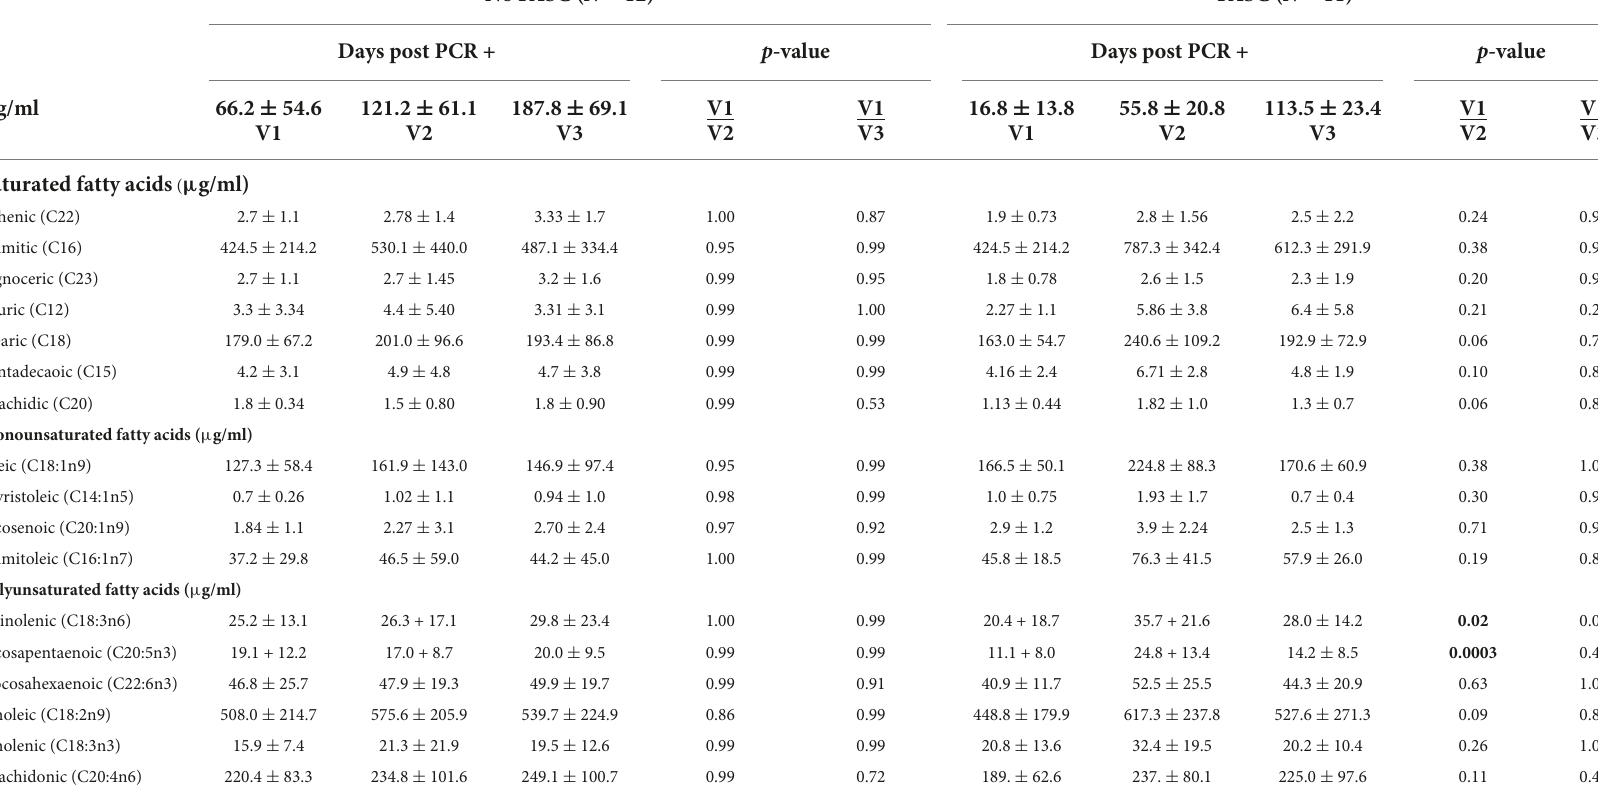
TABLE 3 Lower levels of anti-inflammatory fatty acids during early stages of recovery in adults with post-acute sequelae of COVID-19